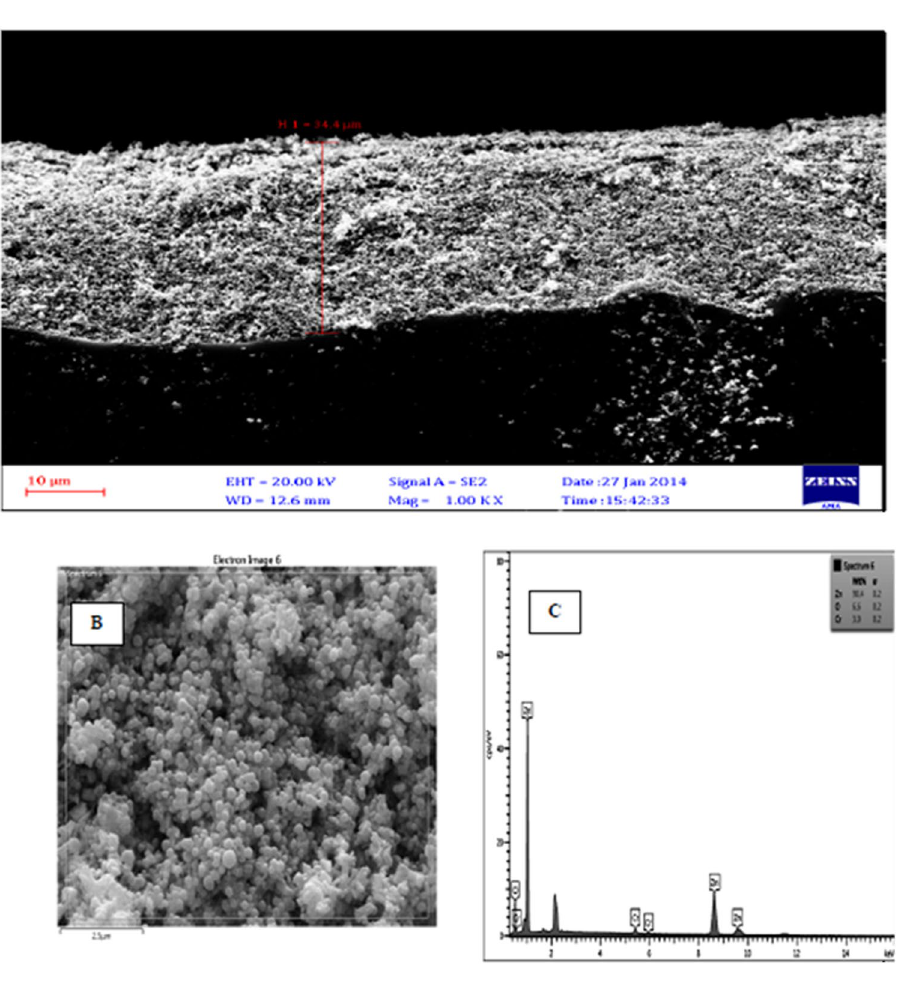
Figure 7. ( A ) Cross sectional SEM image; ( B ) Surface based SEM image; ( C ) EDX diagram based on doped zinc oxide nanoparticles immobilized on the glass plate after the oxidation process.